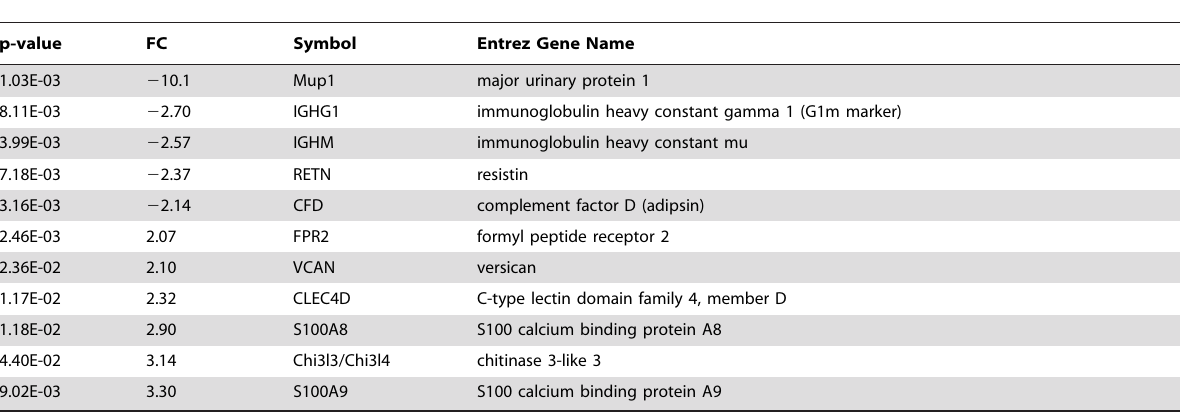
Table 1. Genes differentially expressed in WT vs. H 3 RKO LN at